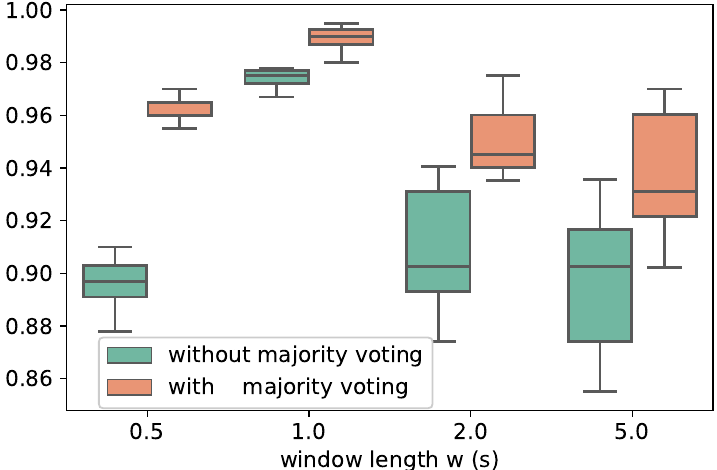
Figure 11. Accuracy with different window lengths w with and without majority voting achieved on a 5 fold cross